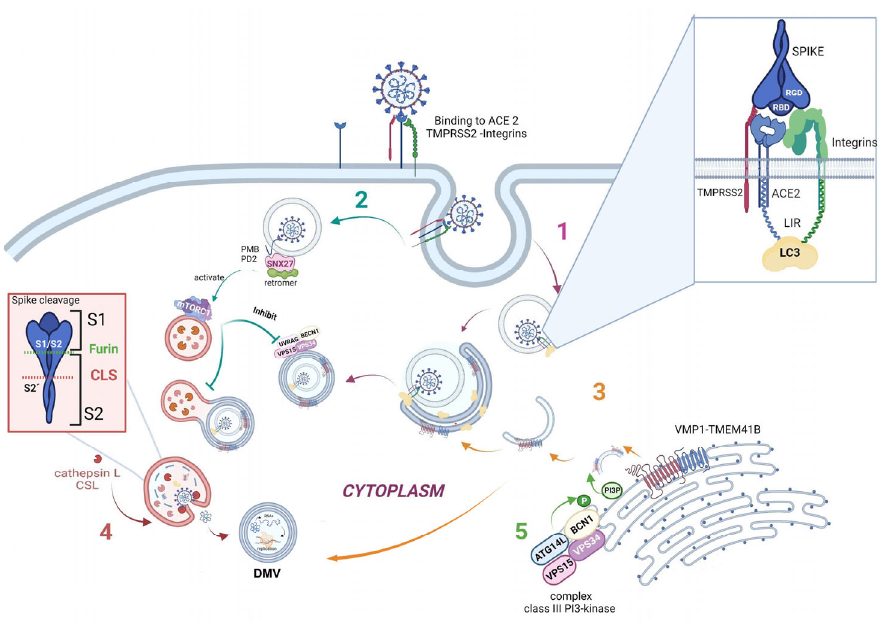
Figure 3. Schematic modeling of the crosstalk between autophagy and SARS-CoV-2 replication pathways . 1—Autophagy may help virus endosomal entry through LC3. 2—Autophagy may be down-regulated by the activation of SNX27 present in the endosomes. 3—VMP1 and